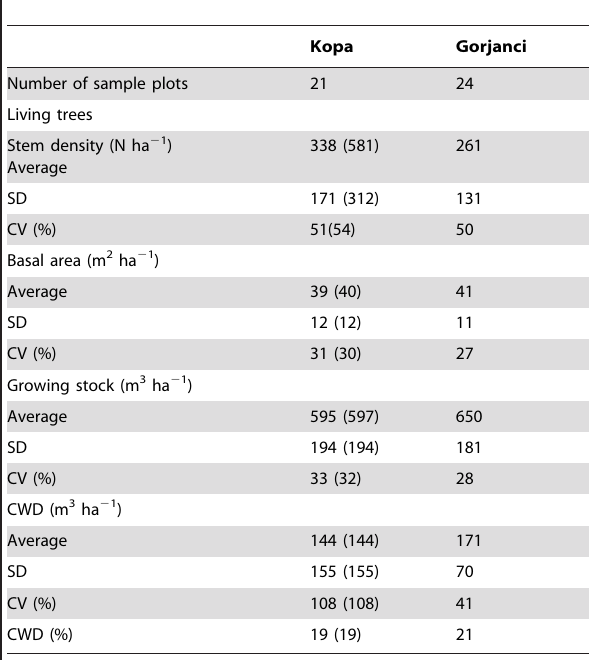
Table 6. Main structural parameters of the Kopa and Gorjanci forest reserves. All parameters measured in the plots were scaled to one